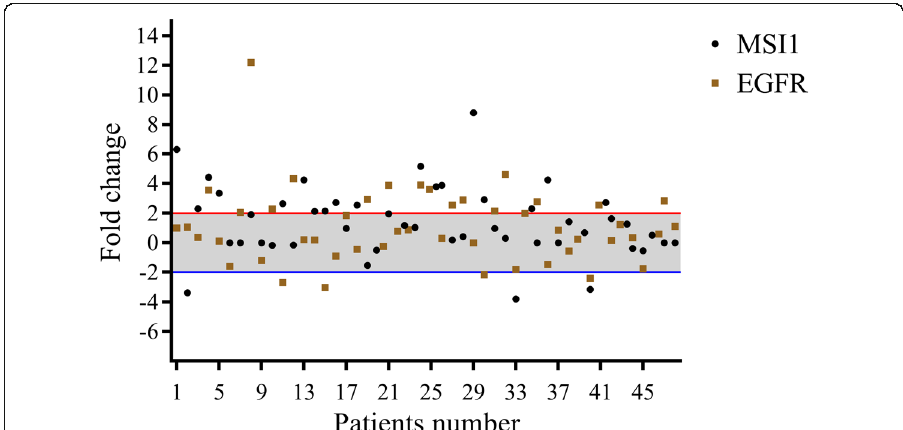
Fig. 1 Descriptive analysis of relative gene expression of MSI1 and EGFR in ESCC patients. The thresholds for the over- and underexpressed cases are shown by red and blue lines, respectively. The grey area refers to the cases with normal levels of EGFR and MSI1 mRNA